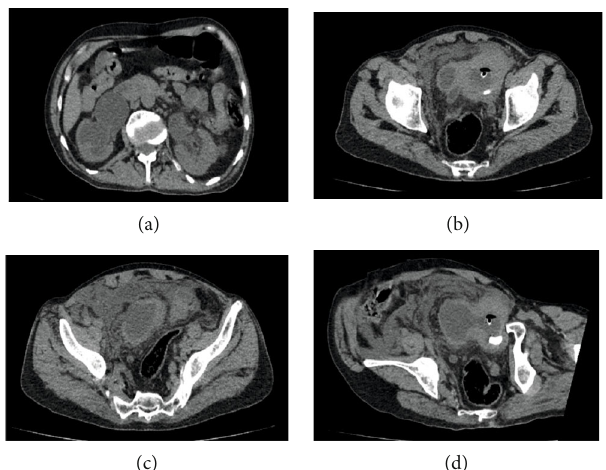
Figure 1: Axial view of CT scan showing (a) bilateral hydroureteronephrosis. (b, d) Empty bladder, associated to a large full bladder diverticulum, with bladder stone and bilateral ureteral dilation. (c) Small amount of free intraperitoneal fl uid leaking from a defect in the bladder diverticulum wall.